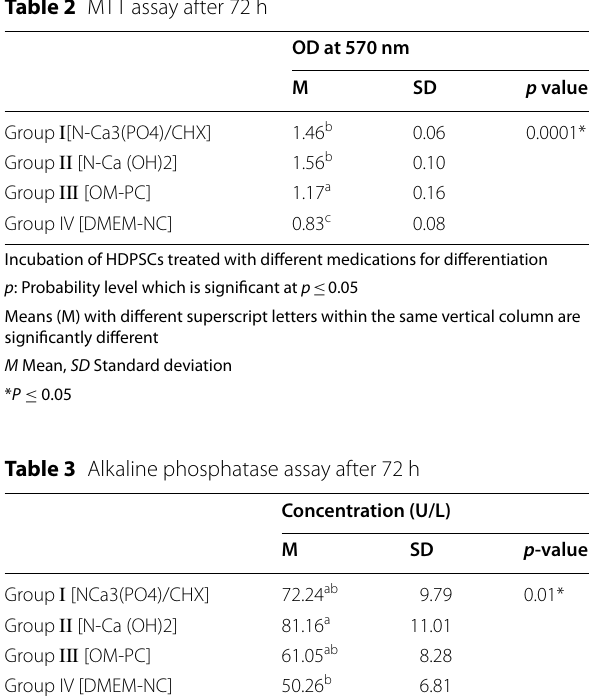
Table 2 MTT assay after 72 h